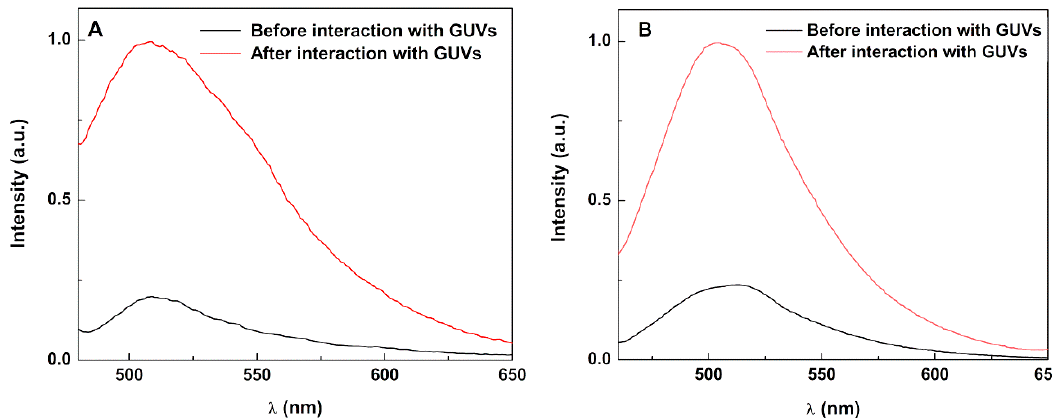
Figure 8. Fluorescence spectra ( λ exc = 440 nm) of curcumin in solid magnetoliposomes (SMLs) containing Ca 0.25 Mg 0.75 Fe 2 O 4 nanoparticles (as an example) before and after interaction with GUVs. ( A ) SMLs of DPPC; ( B ) SMLs of DPPC/DSPE-PEG.